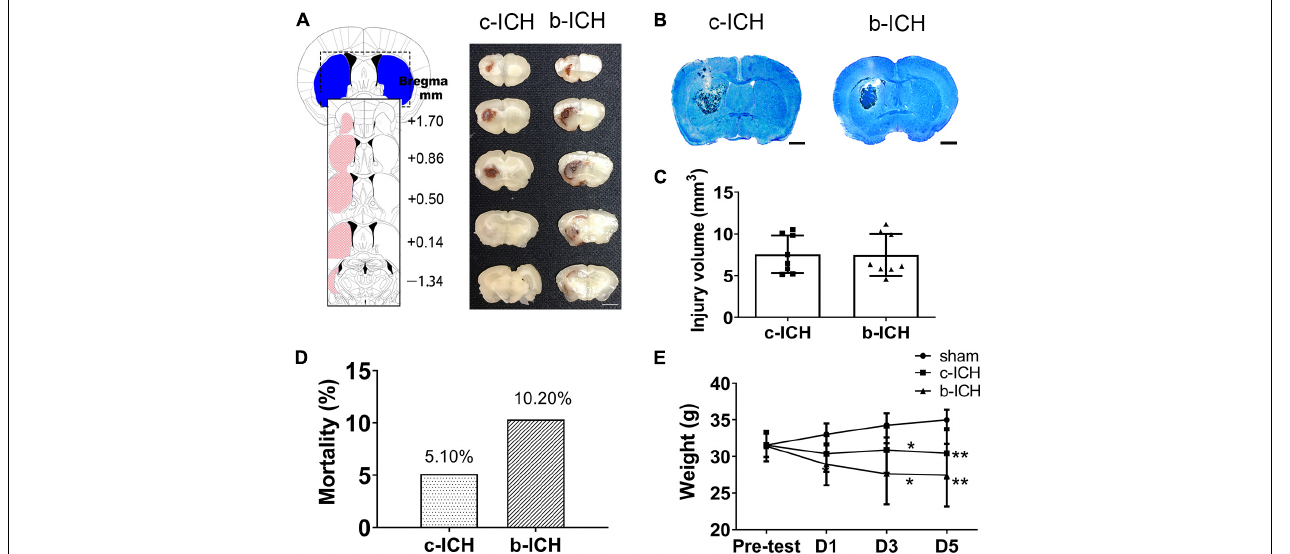
FIGURE 1 | The comparison of injury volume between c-ICH and b-ICH groups. (A) Left: Schematic illustration of the spatial extent of the striatum. Right: Representative fresh brain sections show hematomas (red areas) at 24 h after intrastriatal injection of 0.050 U collagenase (“Collagenase”) or 20 µ L autologous blood (“Blood”). (B) Representative Luxol fast blue/Cresyl violet-stained brain sections from c-ICH and b-ICH groups (scale bar = 1 mm). (C) Injury volume was detected at 24 h after ICH by integration of serial coronal sections stained with Luxol fast blue/Cresyl violet, no difference between the c-ICH and b-ICH model was detected. n = 8 mice/group ( t -test). (D) Overall mortality was determined for all animals used in this study. (E) Bodyweight was measured in all groups on days 1, 3, and 5 respectively. n = 12 mice/group. * P < 0.05, ** P < 0.01 vs. sham group (Repeated measures ANOVA followed by Bonferroni post-hoc test). Data are expressed as mean ± SD (the repeated measures ANOVA followed by the Bonferroni post-hoc test). Values are mean ± SD.